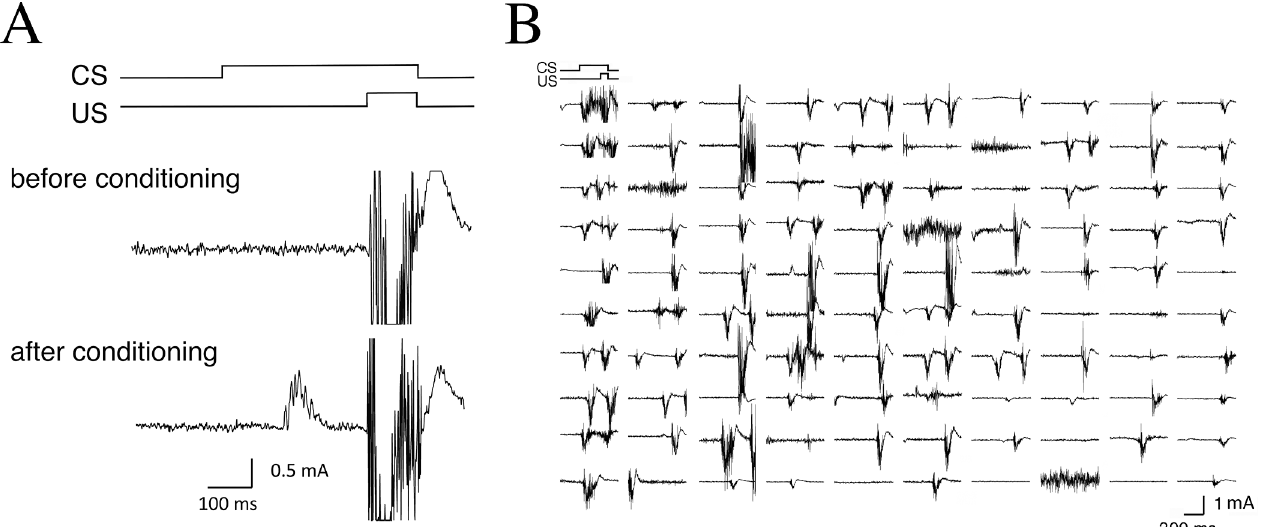
Fig 2. Examples of eyelid EMG responses in monkeys. (A) Typical EMG recordings are shown in the CS-US timing diagram. Before conditioning, the conditioned response (CR) is not observed (upper panel). However, repeated paired presentation of the CS and US results during expression of significant CR before US onset (lower panel). (B) All EMG responses from the 100 trials of 1 typical session on day 5 are shown.